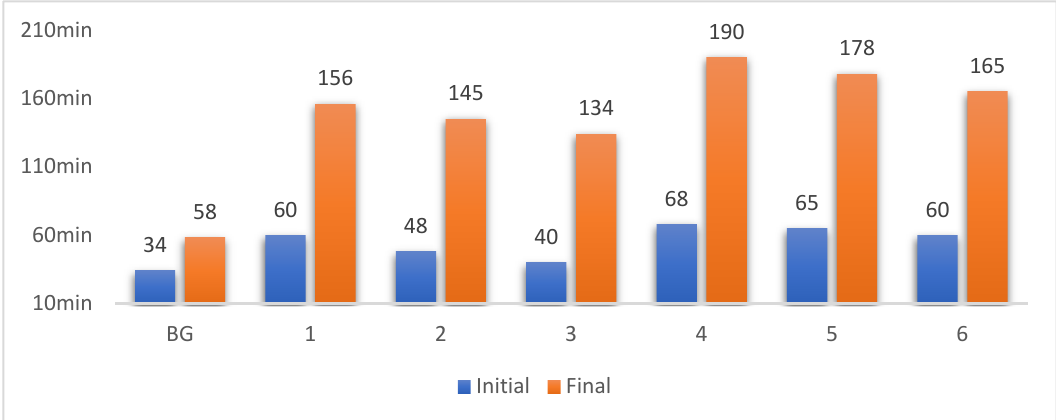
Figure 2. The initial and final setting time of the slurry.